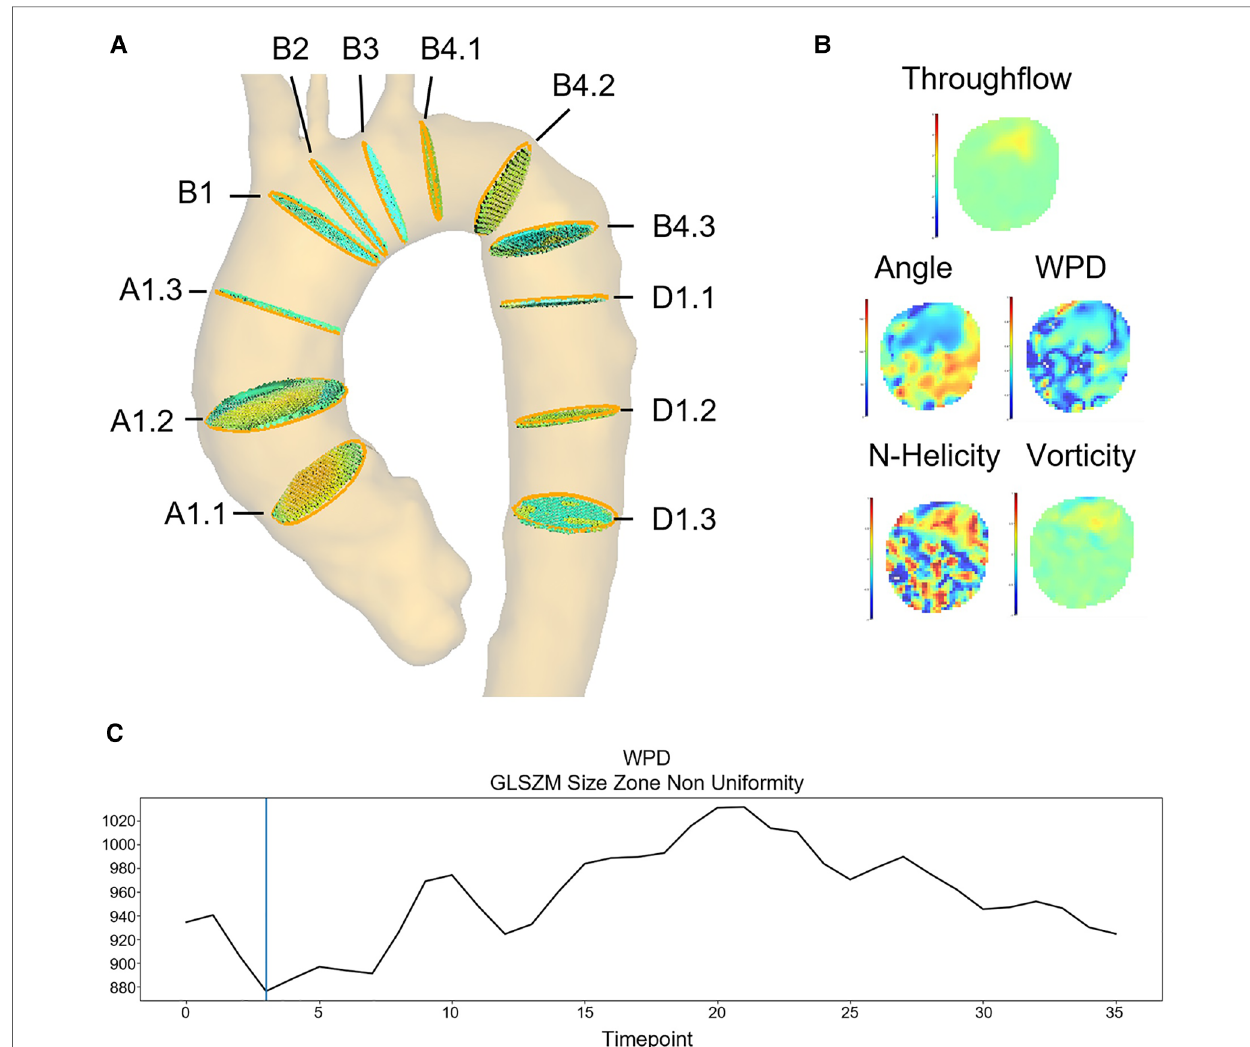
FIGURE 2 Feature extraction example: ( A ) 12 standardized image planes covering the ascending aorta, the aortic arch and the descending aorta. ( B ) Flow parameter maps calculated for each segmented image plane and timeframe (here plane A1.1): through fl ow, angle, WPD, LNH and vorticity. ( C ) Feature curve showing the GLSZM Non-Uniformity based on the WPD map throughout the cardiac cycle on plane